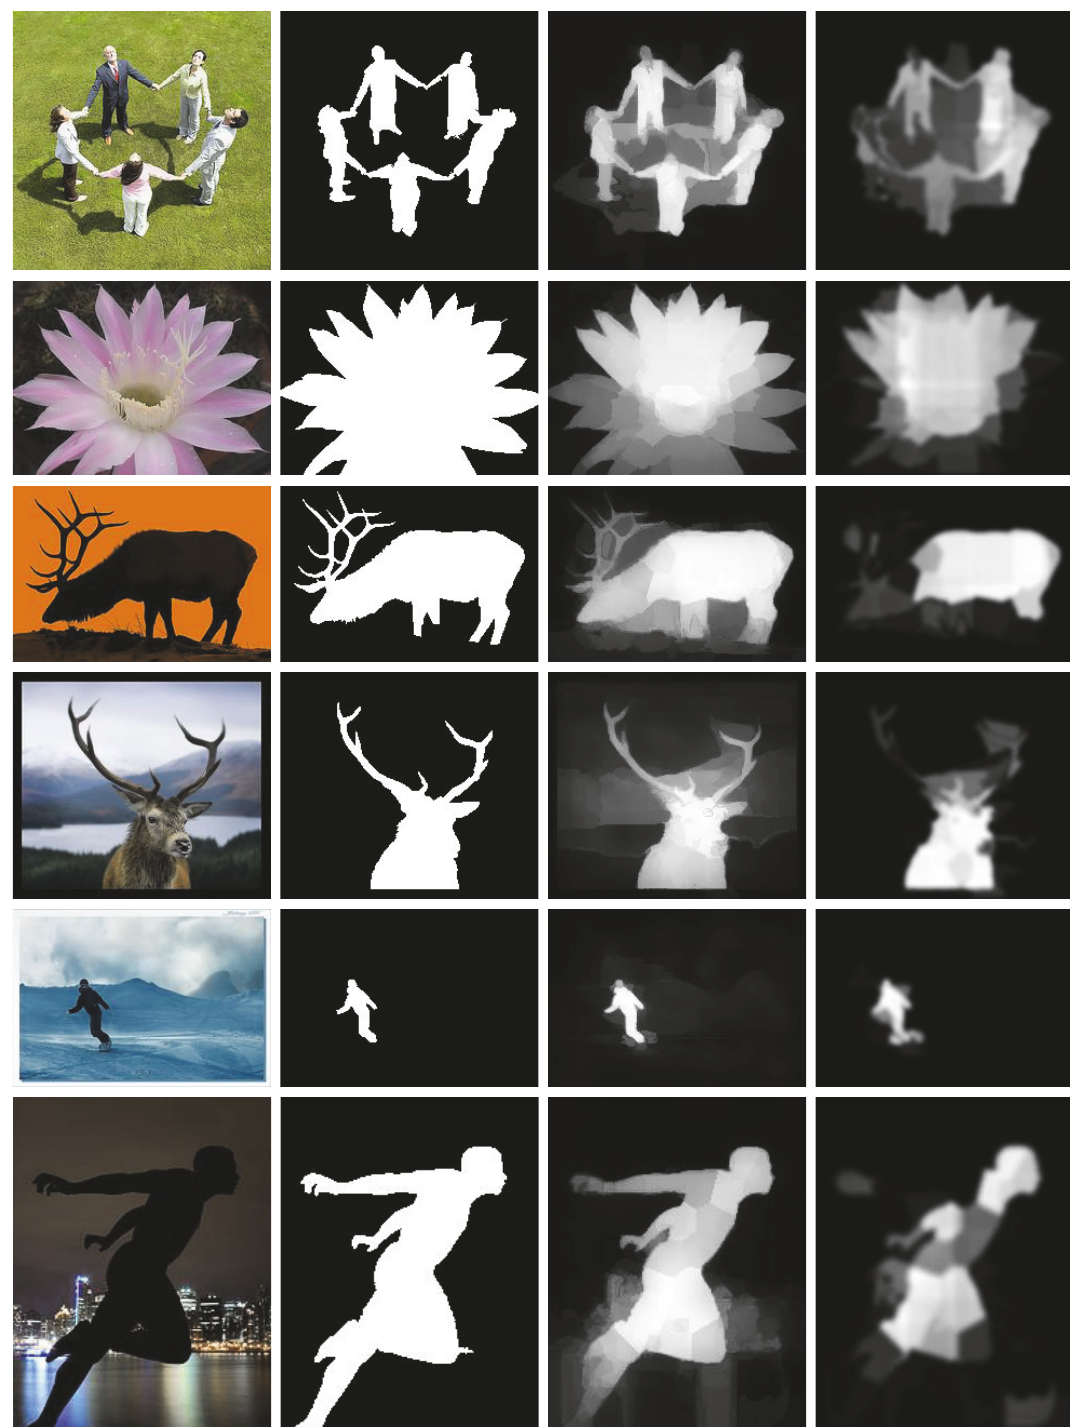
Figure 14: Visual comparisons of FBS with DBS. The order of images is original image, ground truth mask, FBS, and